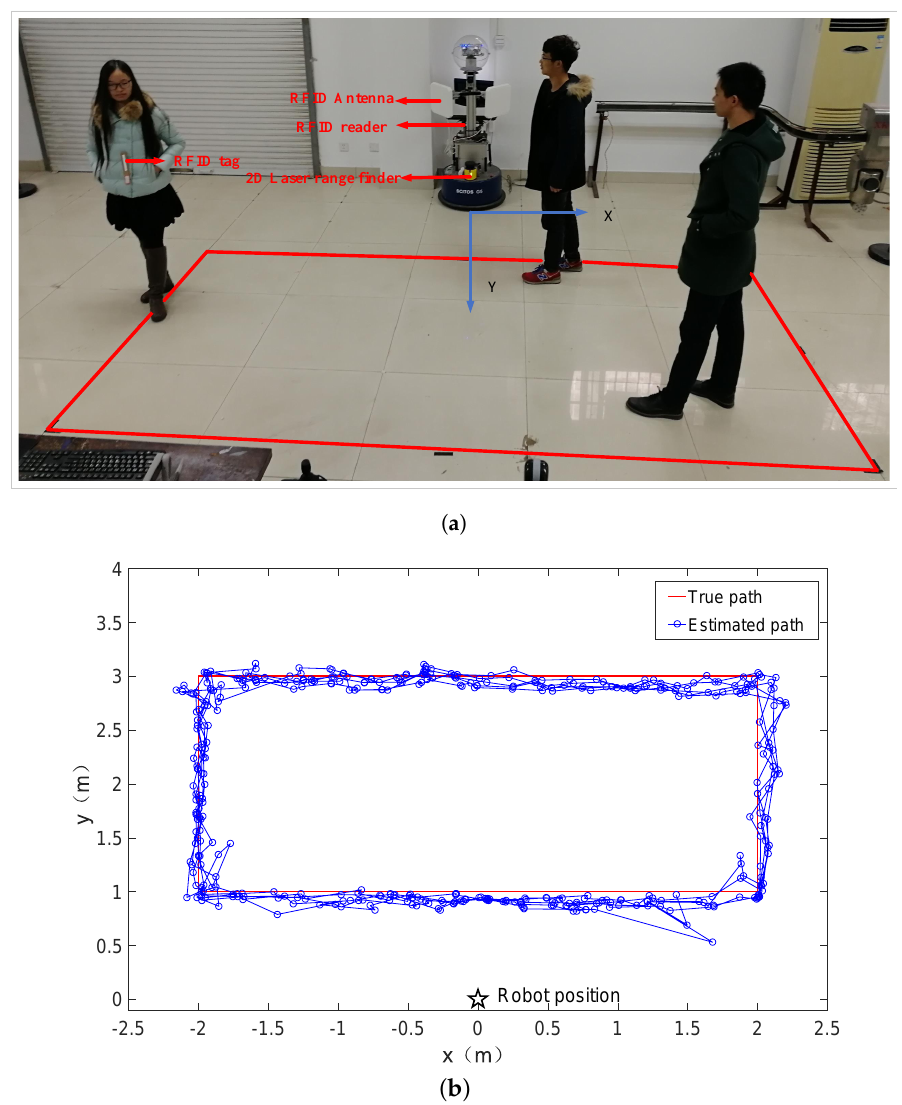
Figure 6. Setup of the experiment and positioning result. ( a ) Setup of the experiment; ( b ) ground truth and estimated track by a combination of two prediction